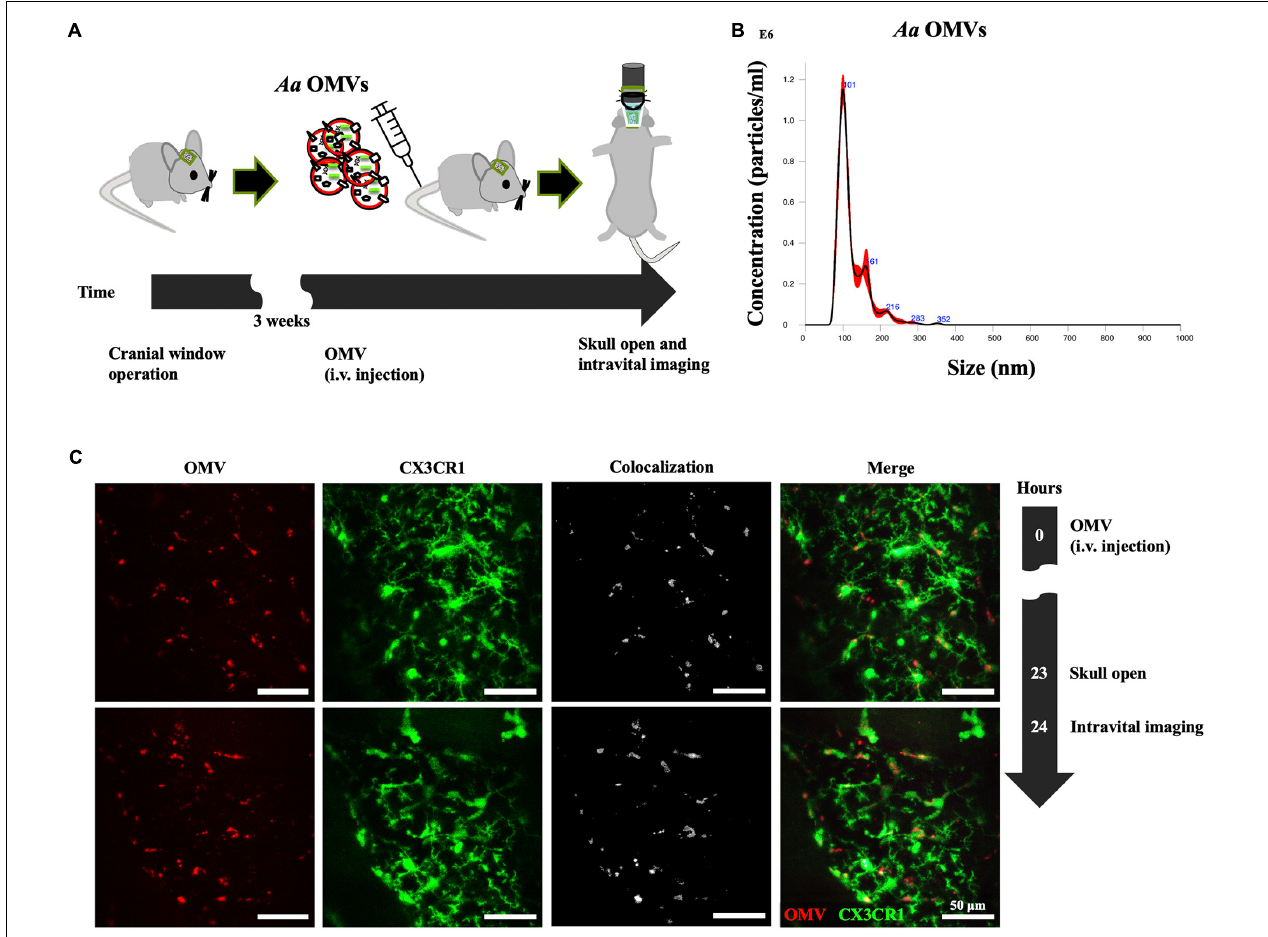
FIGURE 1 | Delivery of Aa OMVs into microglial cells. (A) Schematic diagram of intravital imaging process performed in this study. (B) Nanoparticle tracking analysis (NTA) of Aa OMVs used in this study. OMVs from Aa were analyzed using the NanoSight system to visualize the size distribution ( X -axis) and particle numbers ( Y -axis). (C) Intravital image was captured 24 h after Aa OMV i.v. injection. OMVs were colocalized with GFP-positive microglial cells. Scale bar: 50 µ m. Additional Figures can be found in Supplementary Figure S3